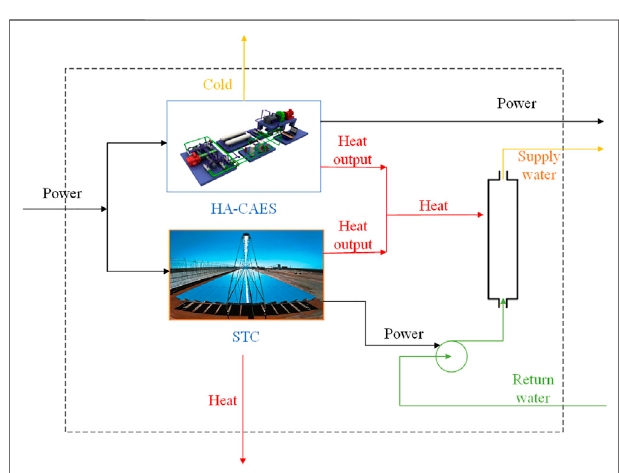
FIGURE 3 | Interface of HA-CAES energy